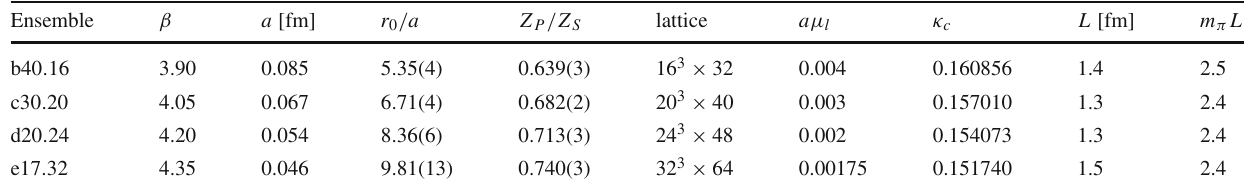
Table 1 Parameters of the employed ETMC N f = 2 gauge field con- figuration ensembles [20–22]. The columns contain: the inverse bare coupling β , the approximate values of the lattice spacing a [28–30], r 0 / a [28,30], the scheme- and scale-independent renormalization con-